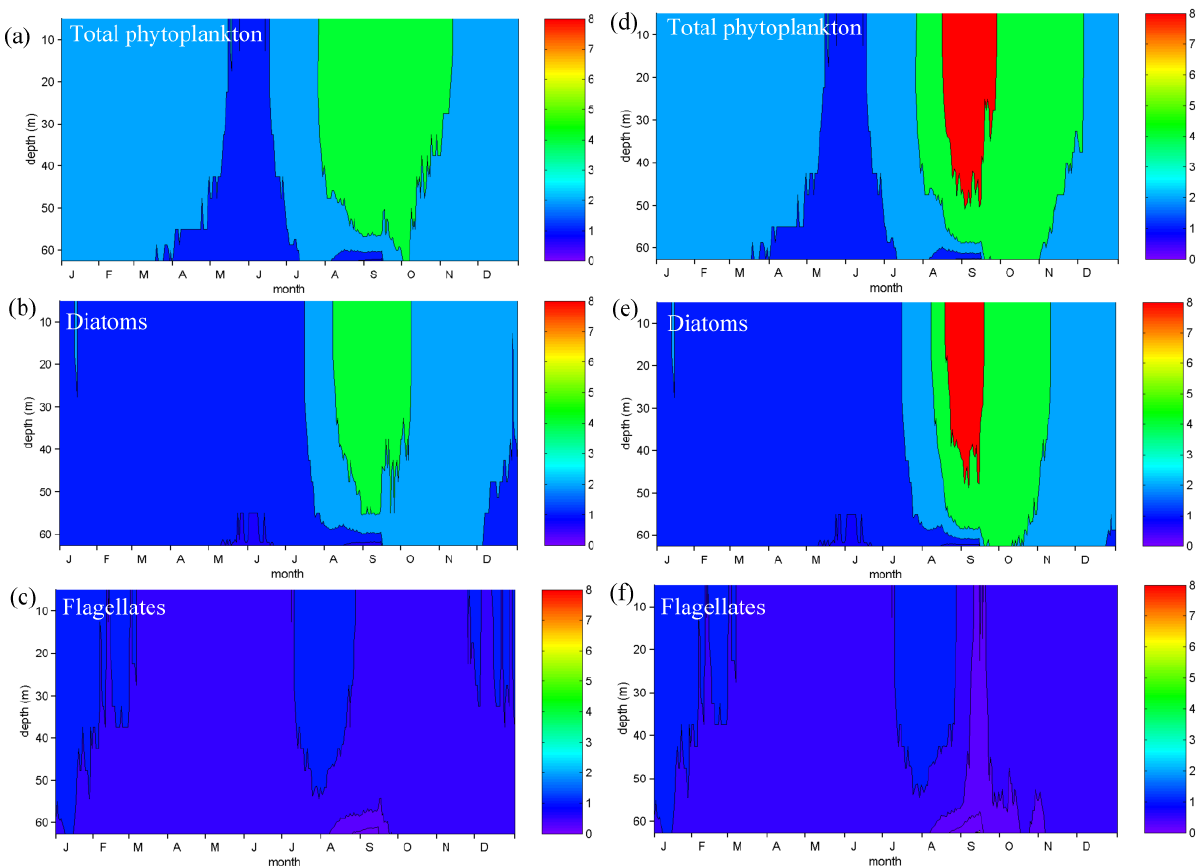
Fig. 5. Temporal evolution of the modelled vertical profile of (a, d) total phytoplankton, (b, e) diatoms and (c, f) non-diatoms in [µmolCL − 1 ] in the upper 63m of the surface ocean at Papa during 2008, (a, b, c ) without and (d, e, f) with iron fertilisation in August 2008.